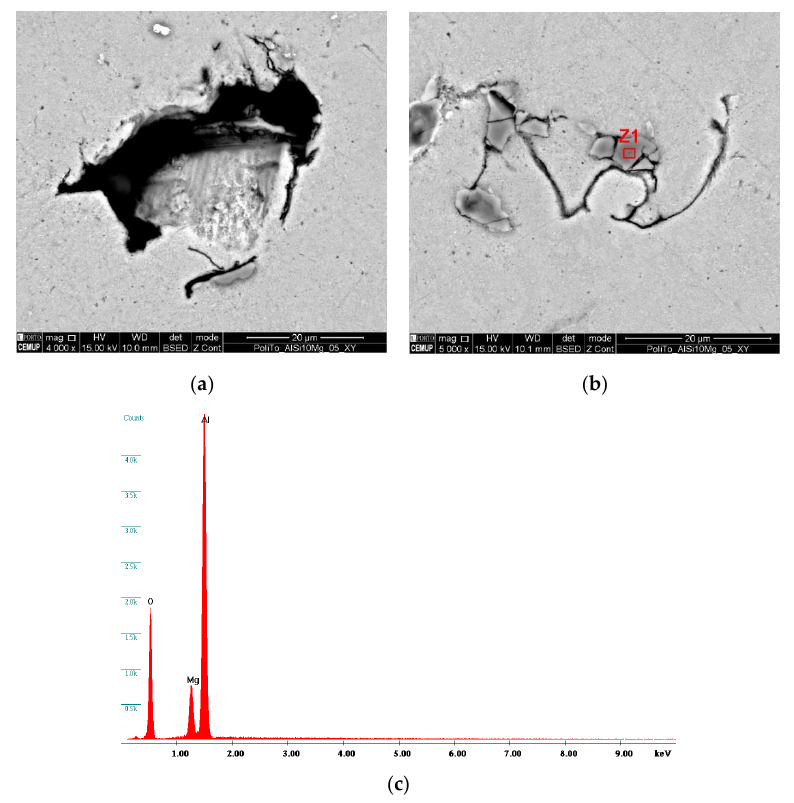
Figure 4. Encountered Defects on Alsi10mg Parts during SEM Analysis; ( a ) Lack of Fusion Pore; ( b ) Identification of Inclusion Marked as Z1; ( c ) analysis of Z1 Inclusion with EDS Equipment, Consistent with an Al–Mg Oxide.